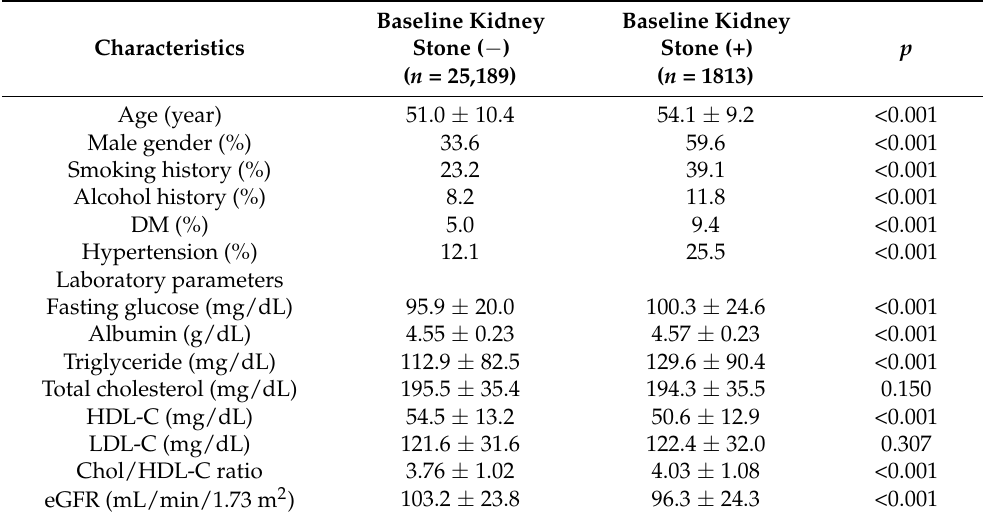
Table 1. Comparison of clinical characteristics among participants according to baseline kidney stone disease in all study participants ( n = 27,002).